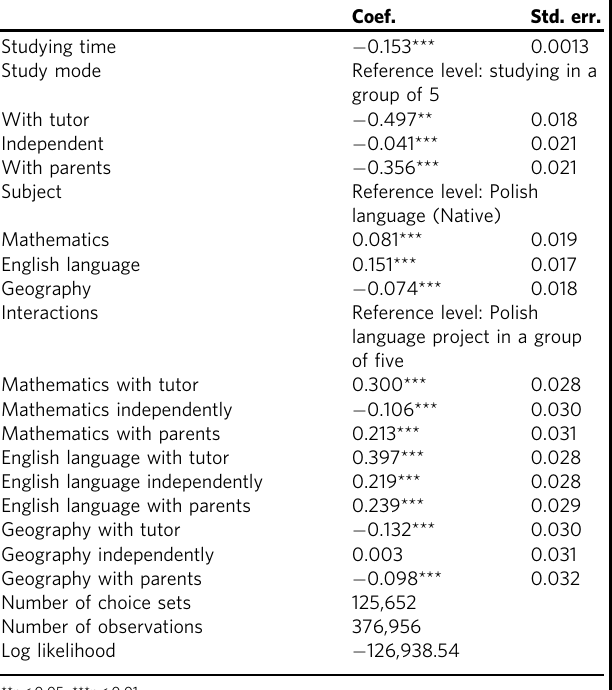
Table 7 Estimated coef fi cients for multinomial logistic regression with the interaction between study mode